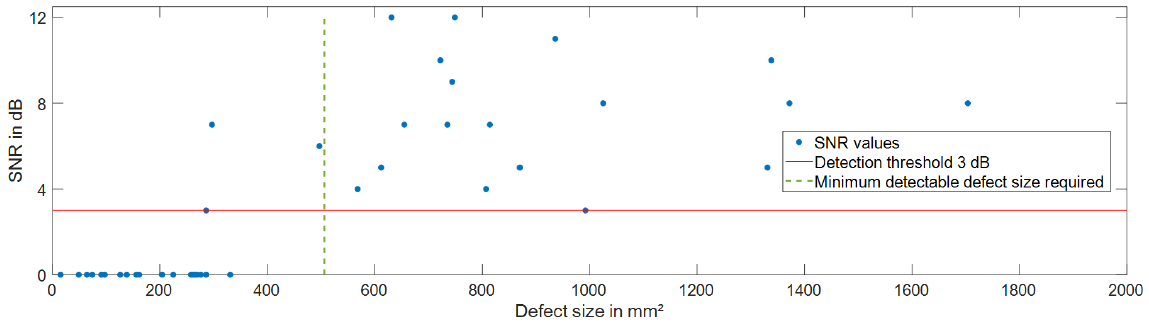
Figure 10. SNR values of all impact damages tested.